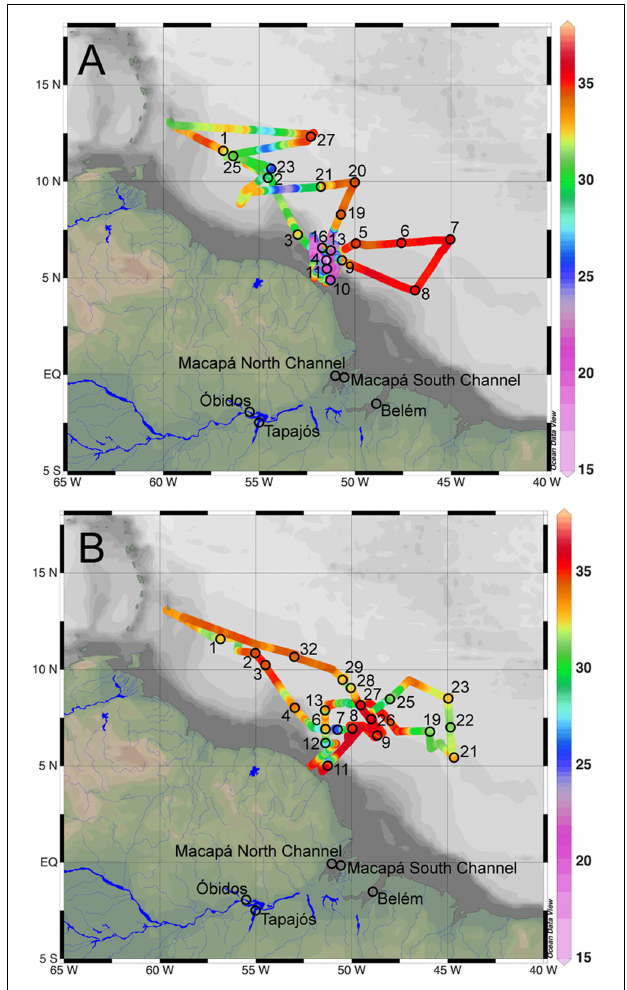
FIGURE 1 | Map of sampling stations from cruises in the Amazon River plume aboard the R/V Knorr in May/June 2010 (A) , and the R/V Melville in September 2011 (B) . Amazon River sampling stations from September 2010, December 2010, and May 2011 are indicated on both maps. Surface water salinity along cruise tracks are indicated with